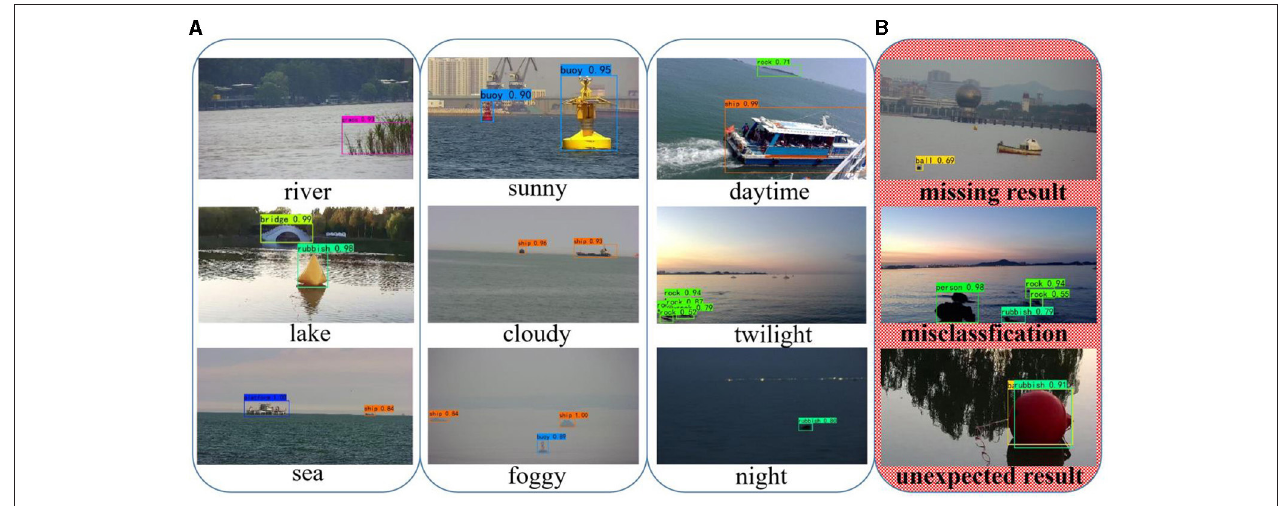
FIGURE 9 | Detection results of CRB-Net. (A) Good detection effect (different environments, weather conditions and shooting times). (B) Poor detection